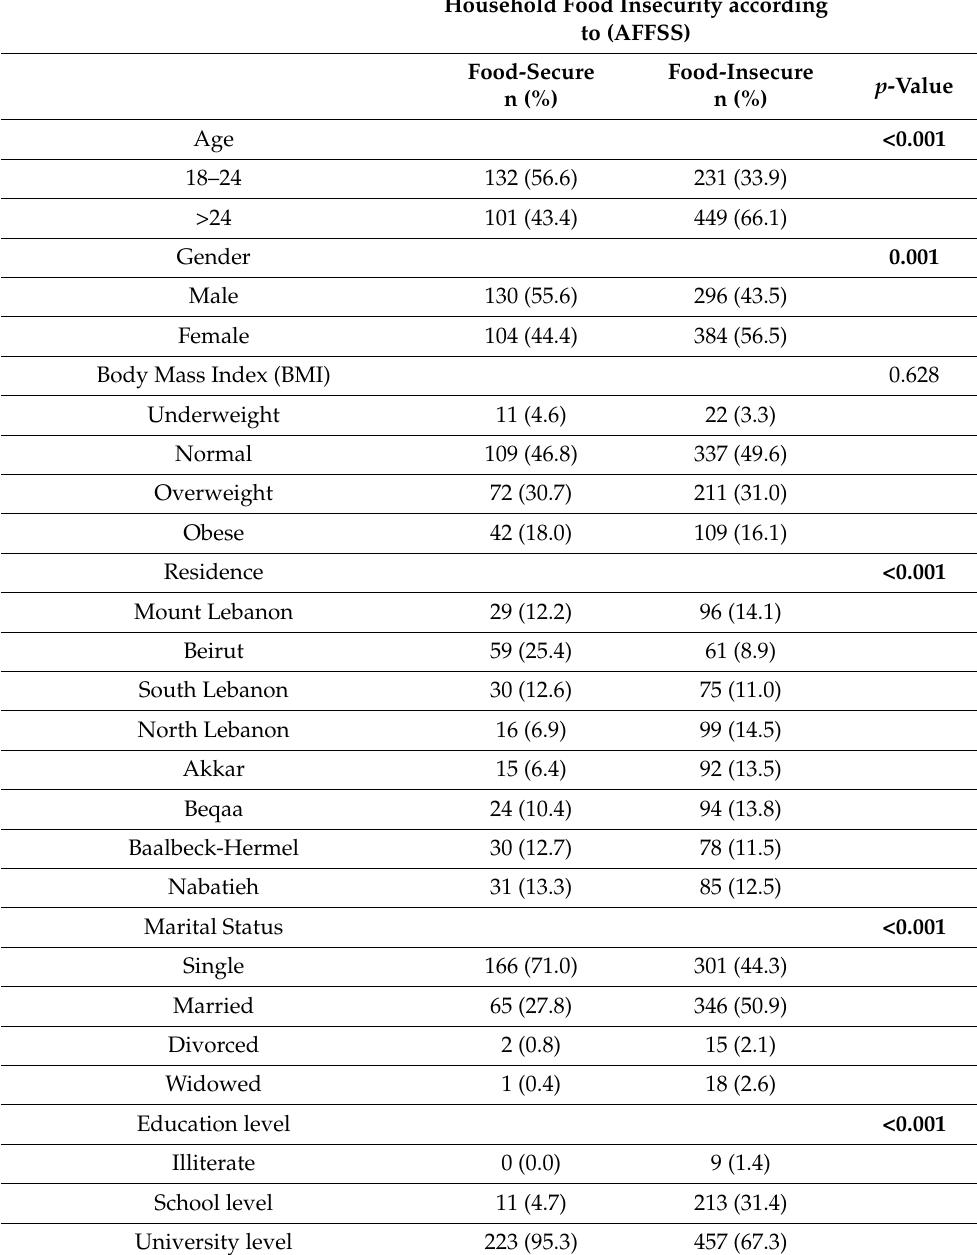
Table 5. The association of demographic and socioeconomic characteristics with household food insecurity. Household Food Insecurity